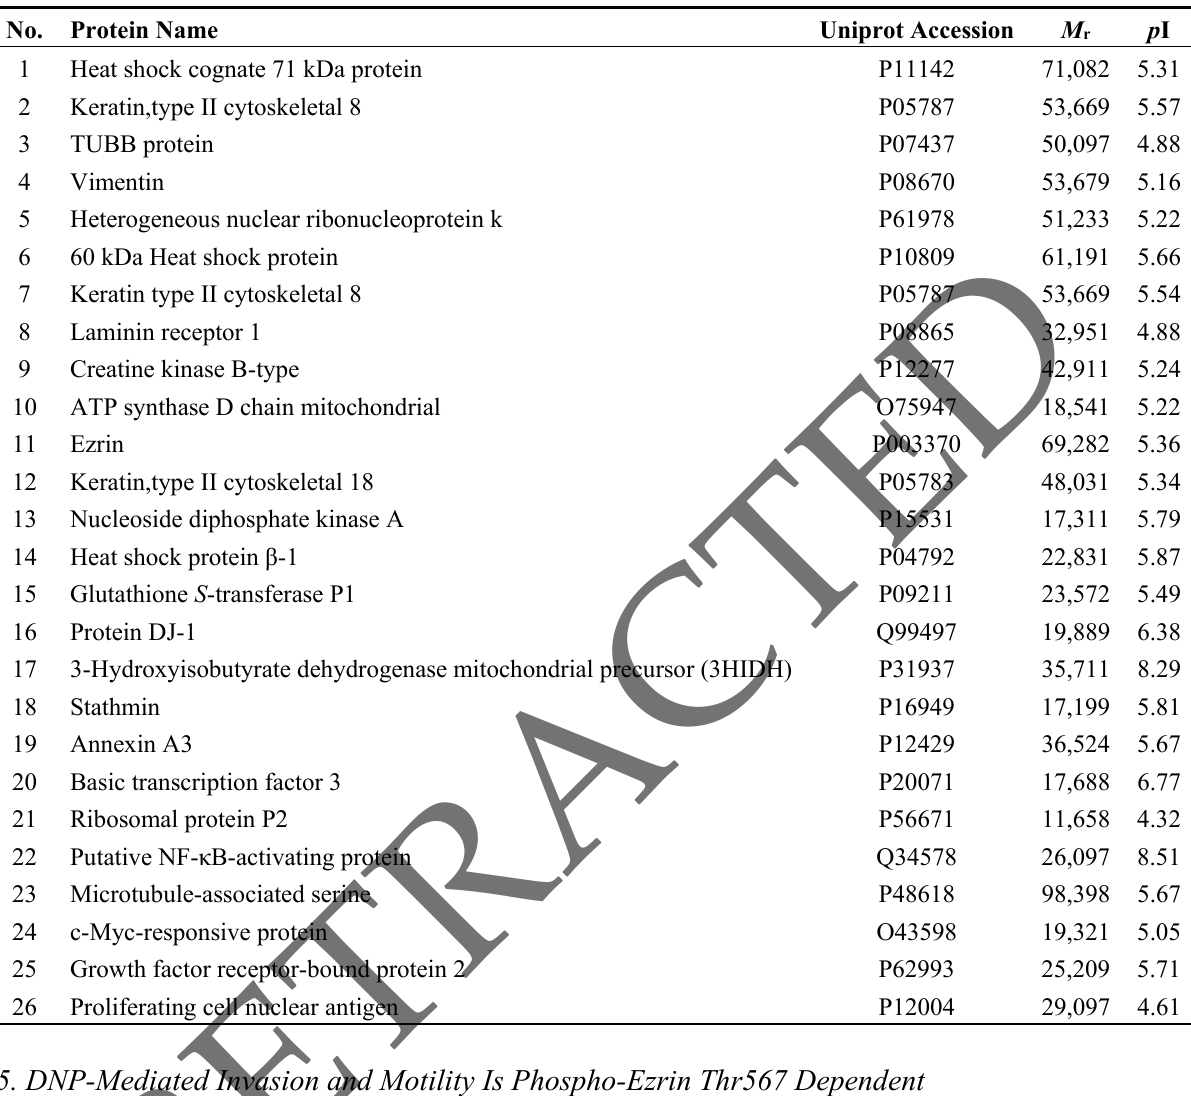
Table 1. Identification of differential phosphoproteins in DNP-treated NPC cells by 2D-DIGE and